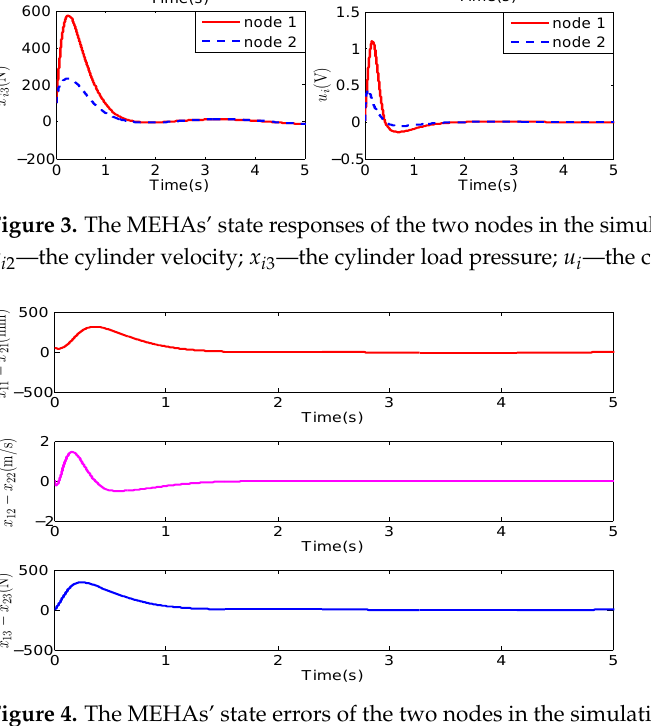
x 22 (the pink line) —the cylinder velocity error; x 13 −